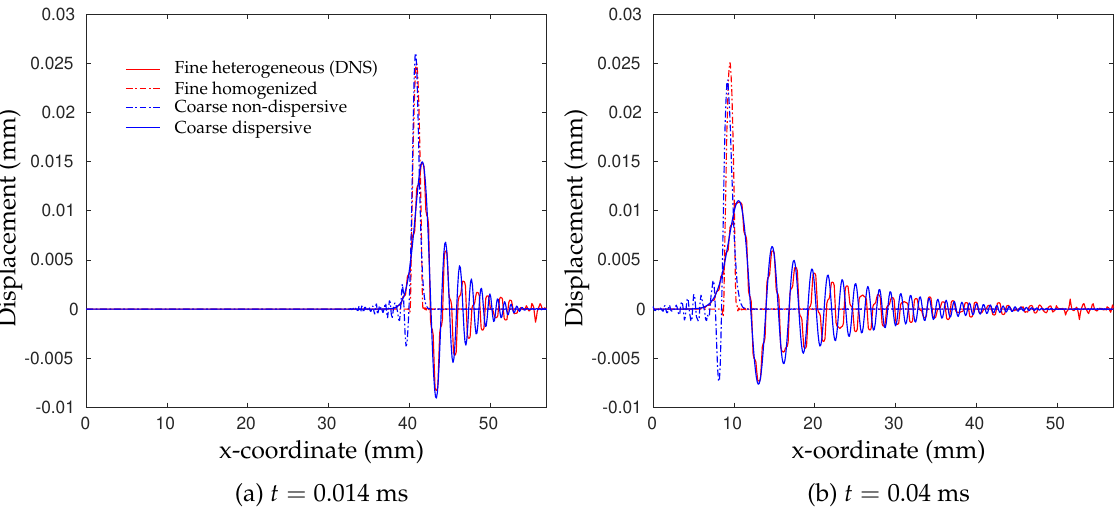
Figure 16. Plots of the displacement field at different time